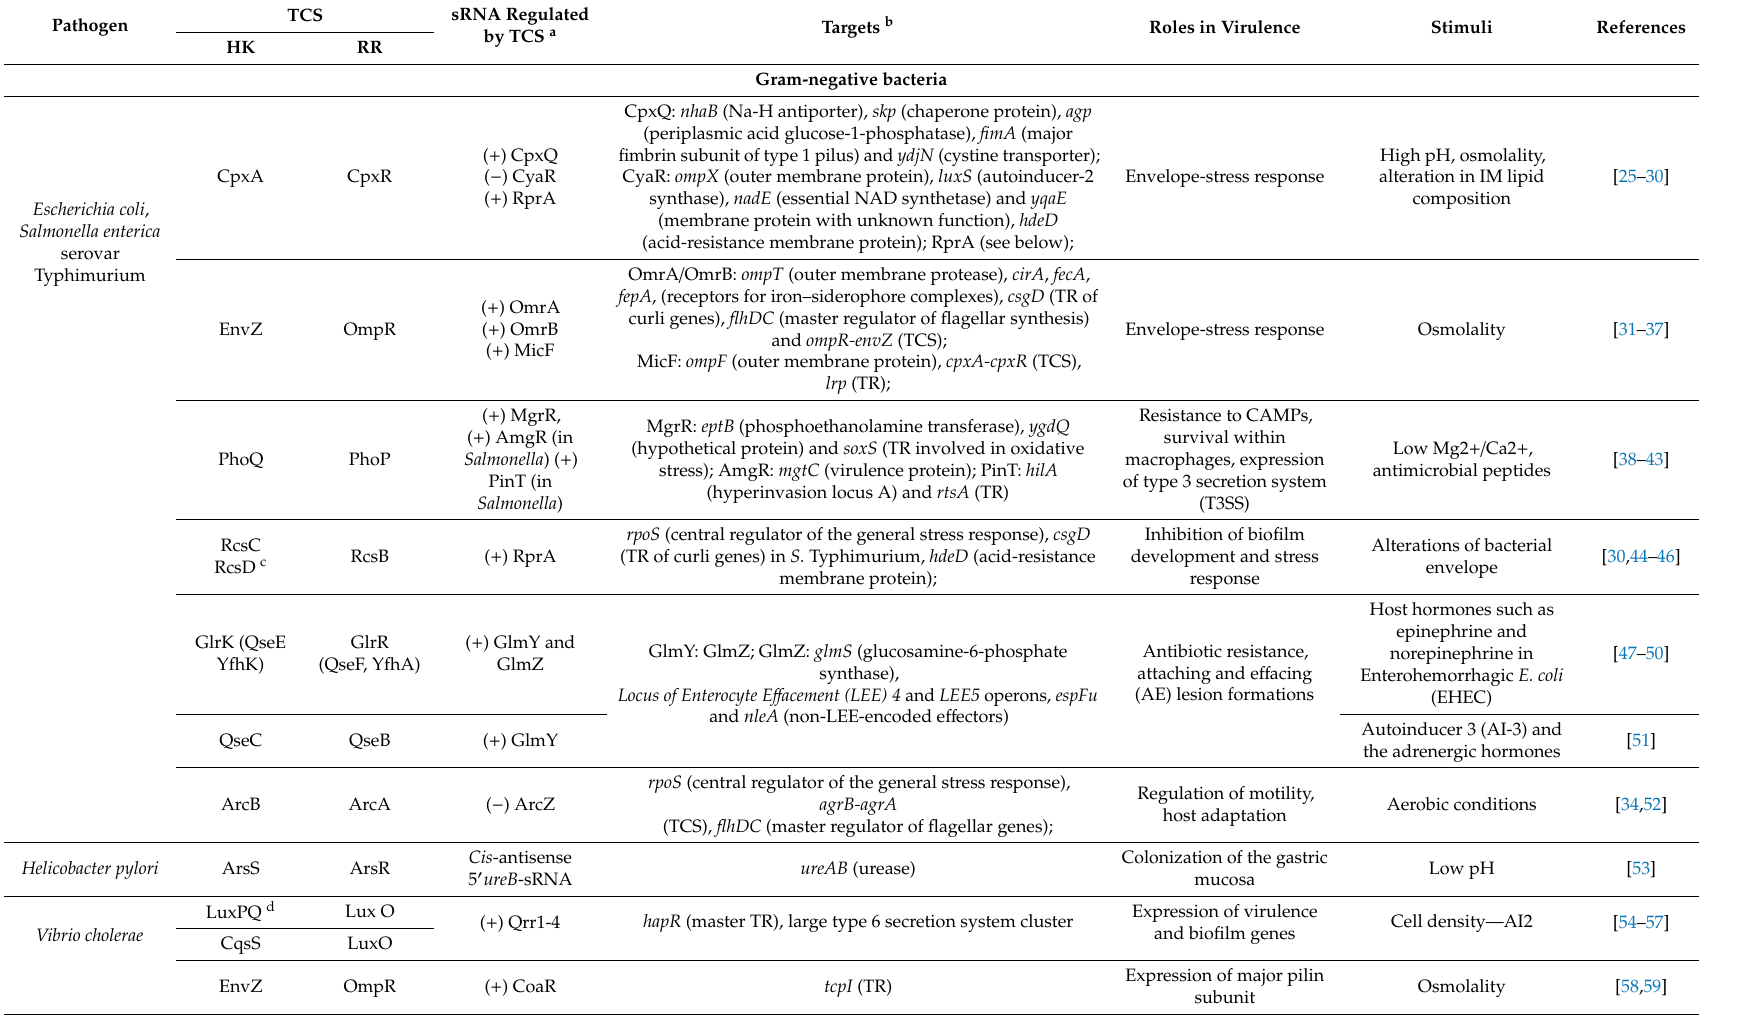
Table 1. Examples of TCS-associated sRNAs in Gram-negative and Gram-positive bacterial